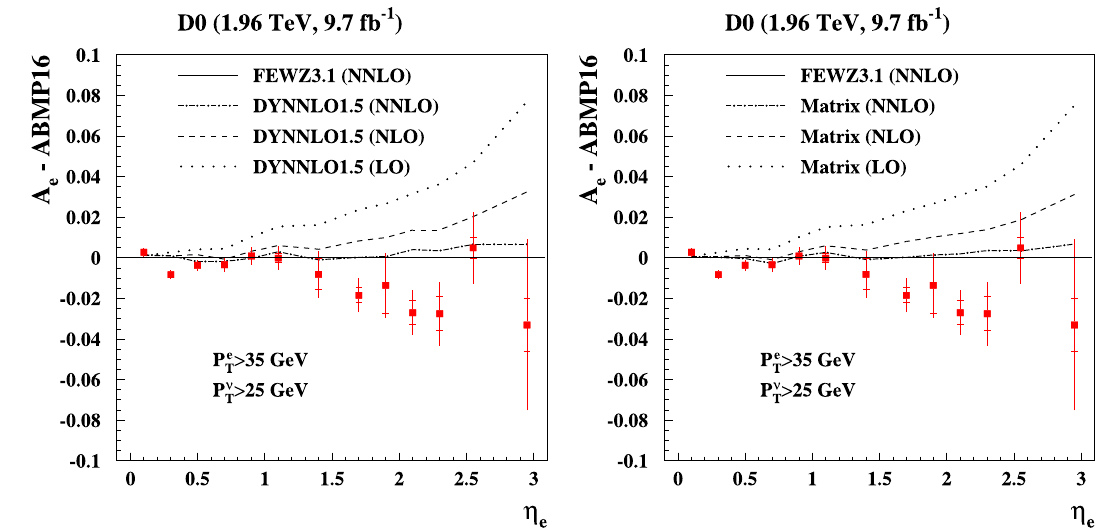
> p ν on the decay leptons as indicated in the figure for the DYNNLO code (left) and the T T